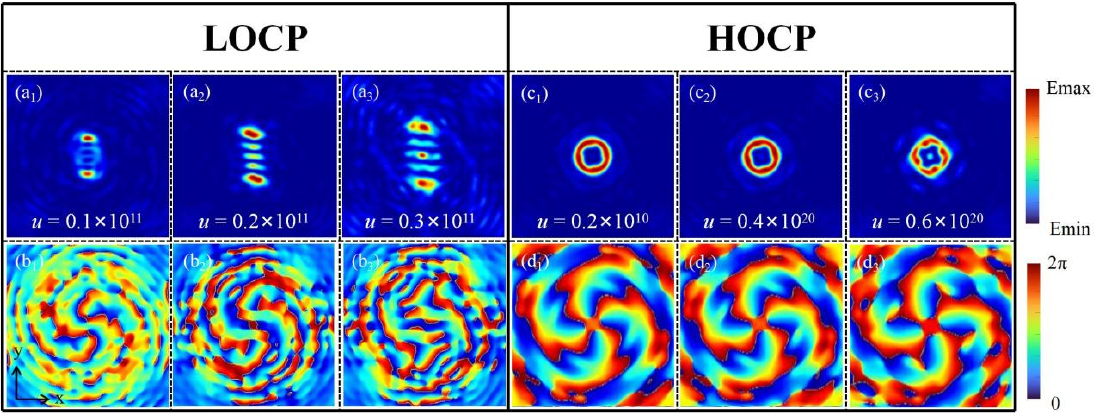
Figure 10. The influence of different u values on LOCP and HOCP. ( a ) LOCP light field distribution. ( b ) LOCP phase distribution. ( c ) HOCP light field distribution. ( d ) HOCP phase distribution.